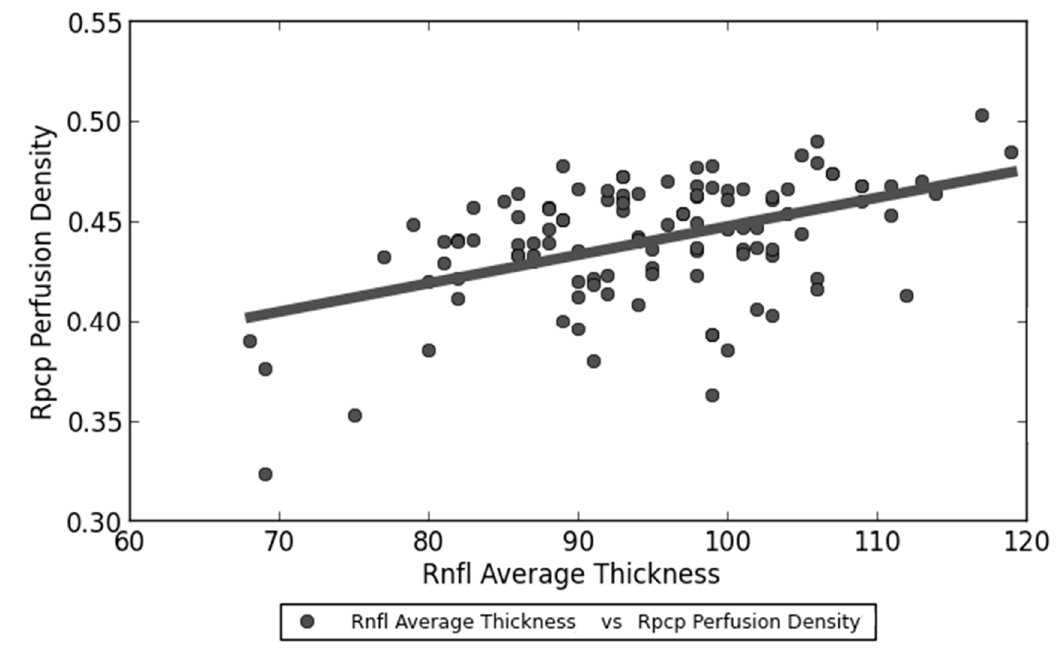
Figure 3. Linear correlation between RNFL (Retinal nerve fiber layer) average thickness and RPCP (Radial peripapillary capillary plexus) perfusion density within post-COVID-19 group patients.